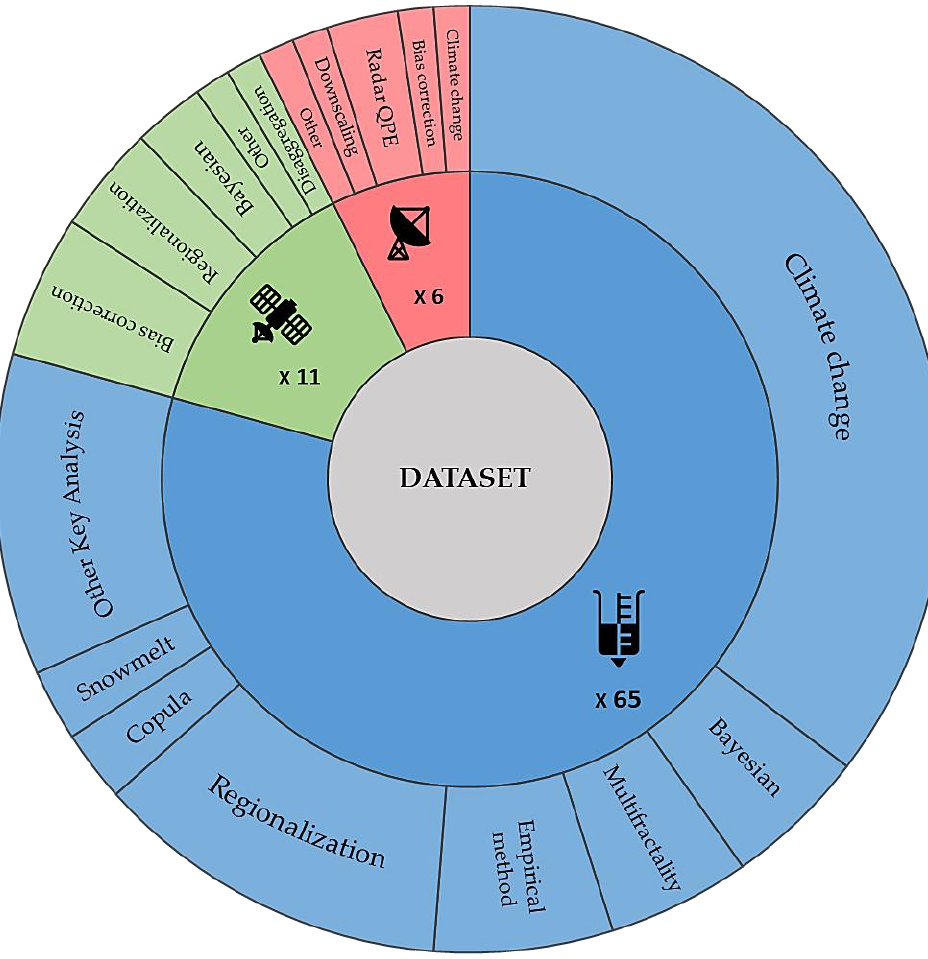
Figure 2. Number, categories, and subcategories of studies based on rain gauges ( in blue ), satellite products ( in green ), and weather radar ( in red ).